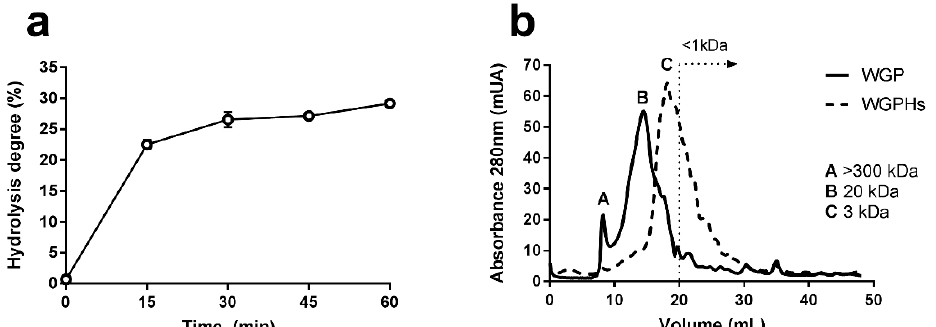
Figure 1. ( a ) Time-course of hydrolysis of WGP by the endopeptidase Alcalase 2.4 L. The data represent the mean and the standard error of the mean of the cleavage of peptide bonds of four determination. ( b ) Molecular weight profiles of WGP and WGPHs obtained by size-exclusion using fast performance liquid chromatography (FPLC). Abs, absorbance at 450 nm; WGP, wheat gluten protein; WGPHs, wheat gluten protein hydrolysates.